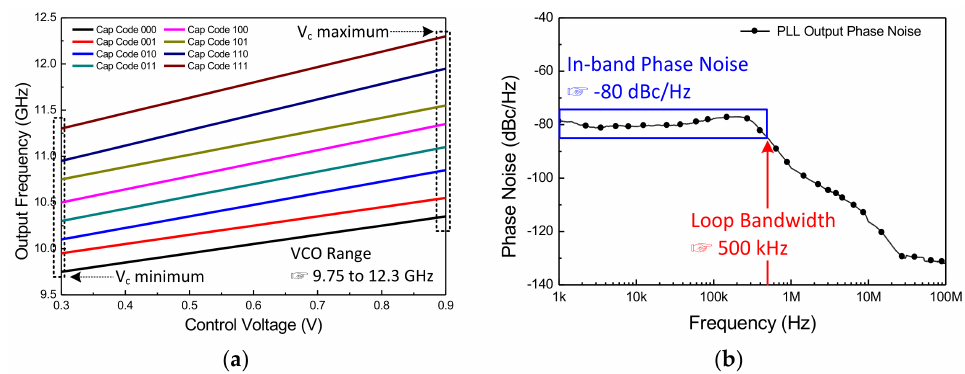
Figure 21. The output frequency of the VCO is shown in ( a ); and the measured phase noise performance at the frequency of 10.525 GHz is described in ( b ).